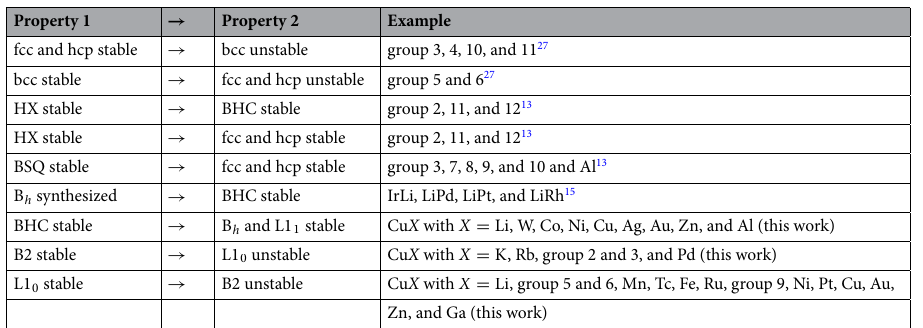
Table 1. The interrelationship of the dynamical stability between different structures. The “stable” structure has no imaginary frequencies within the phonon Brillouin zone.